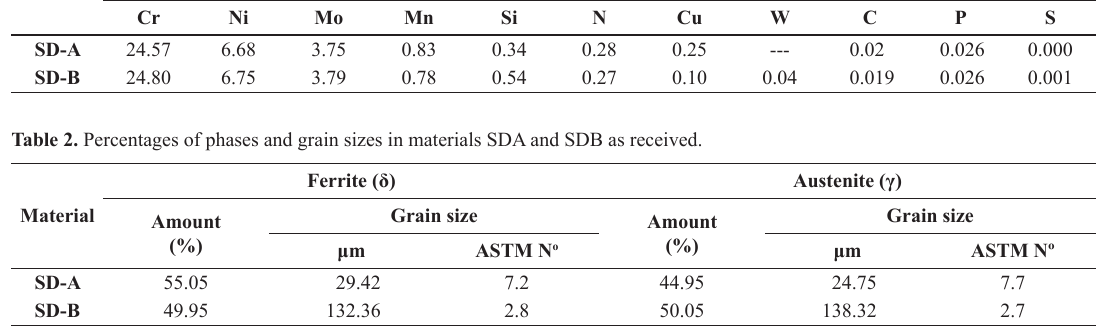
Table 1. Chemical compositions of the materials studied. Material